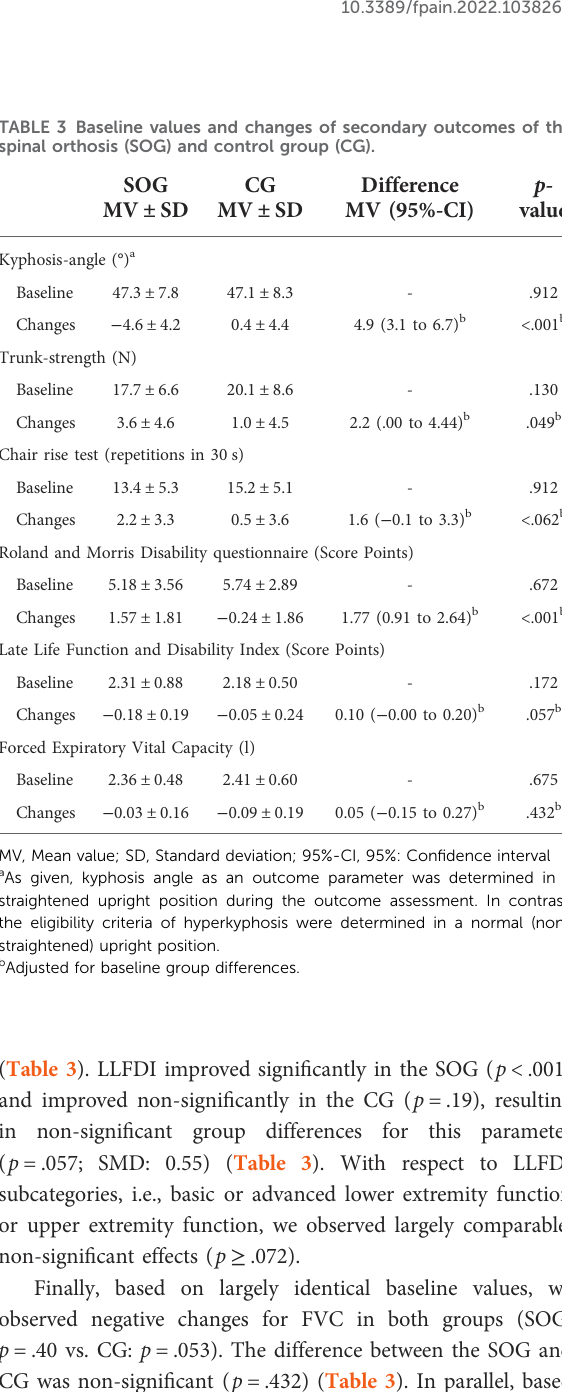
( Table 3 ). LLFDI improved signi fi cantly in the SOG ( p < .001) and improved non-signi fi cantly in the CG ( p = .19), resulting in non-signi fi cant group differences for this parameter ( p = .057; SMD: 0.55) ( Table 3 ). With respect to LLFDI subcategories, i.e., basic or advanced lower extremity function or upper extremity function, we observed largely comparable,